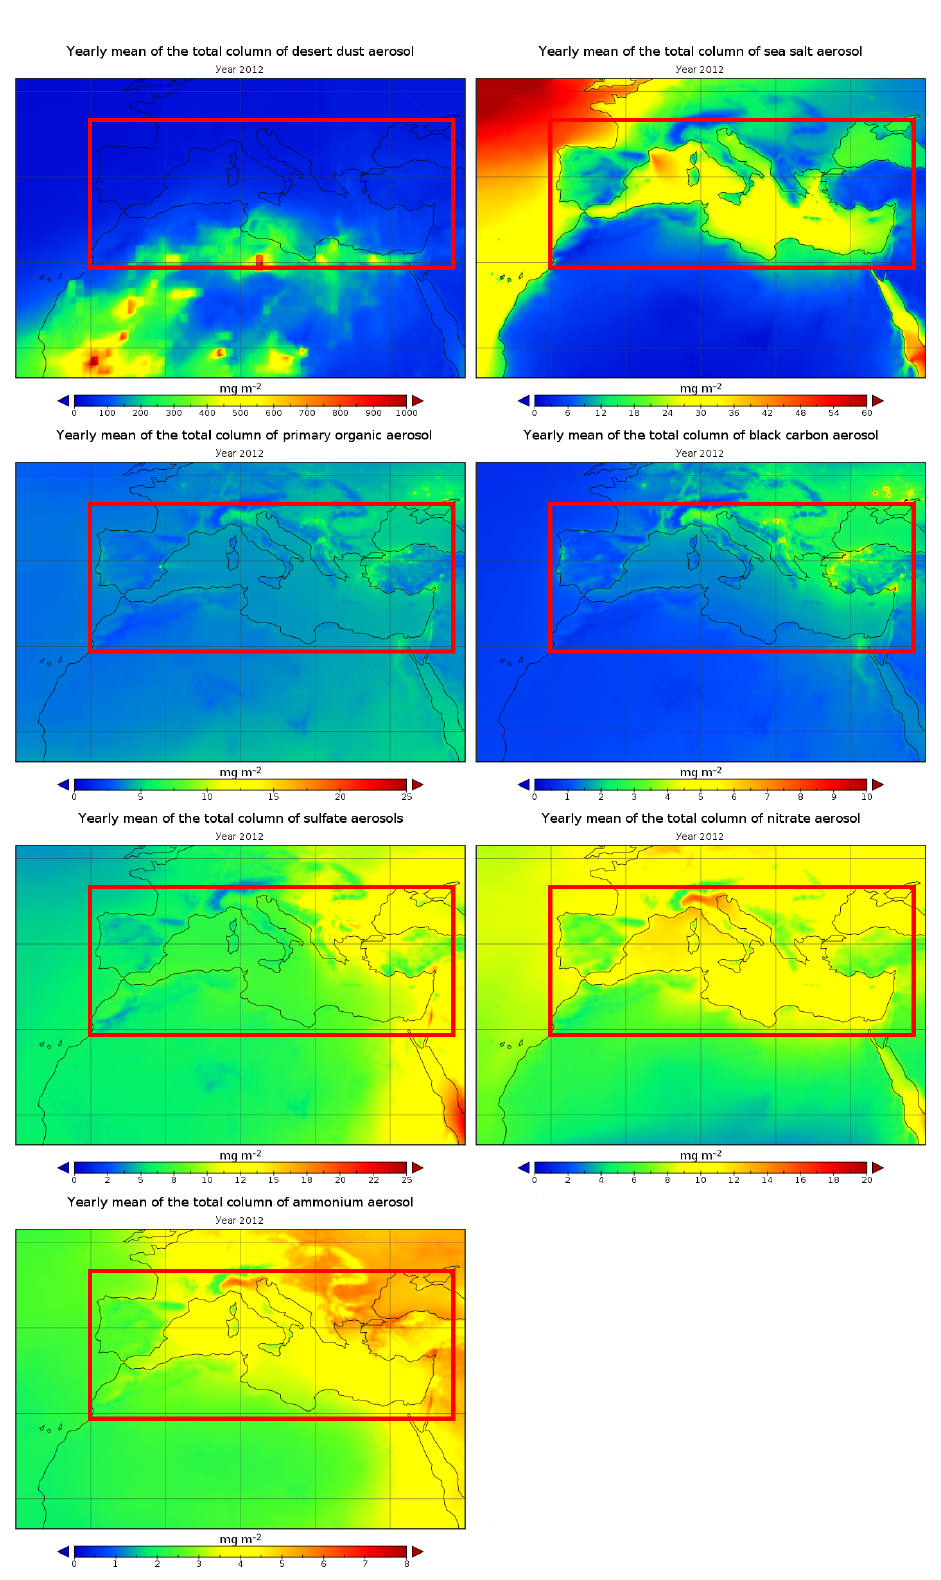
Figure 4. Yearly mean of the total column of aerosols for the year 2012. The red square on the figures represents the budget